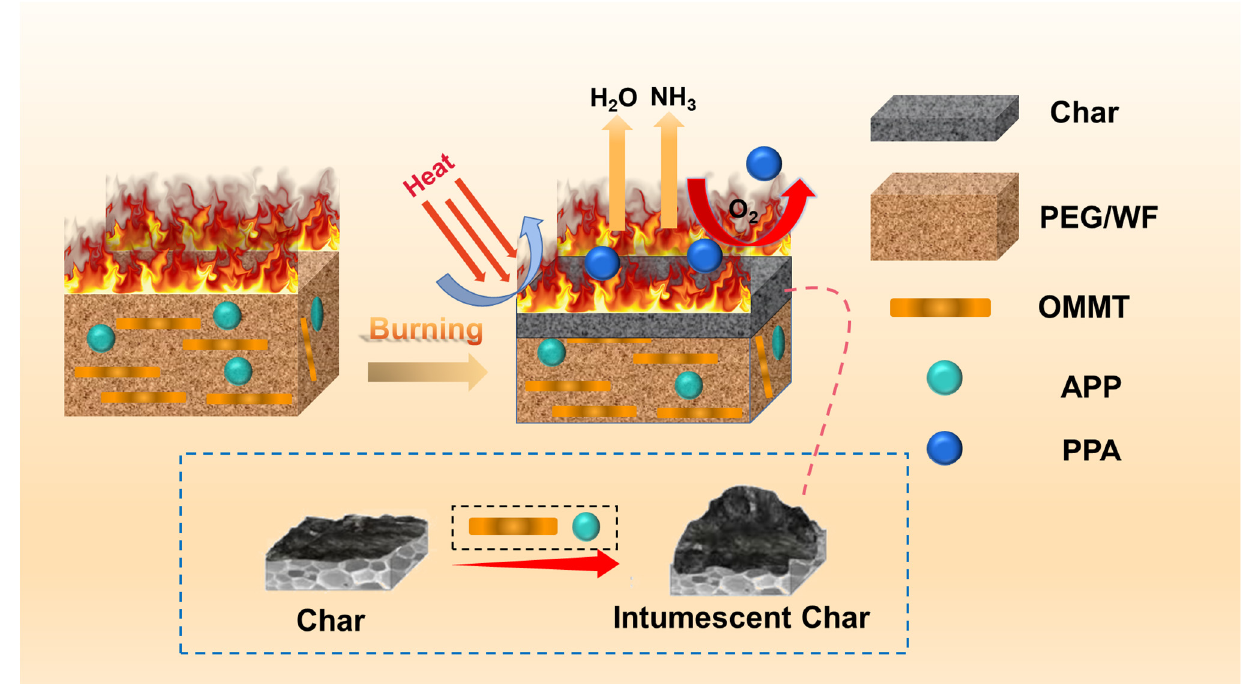
Figure 10. Schematic illustration of the fl ame retardant mechanism of RPUF composites.